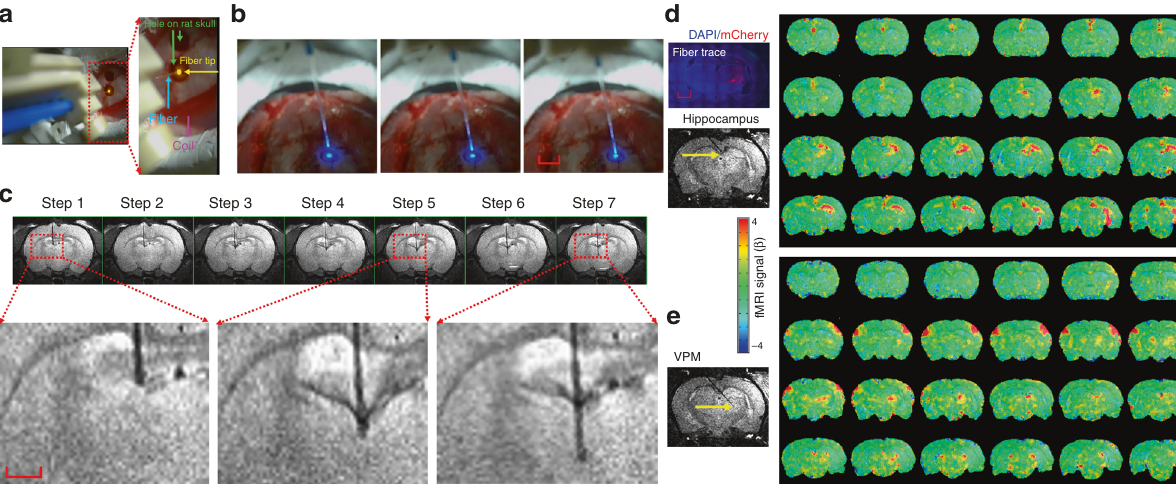
Fig. 2 Evaluation of MgRA for in vivo studies and brain-wide opto-fMRI patterns in multiple targets. a Snapshot of the optical fi ber (tip with 589 nm wavelength laser light, yellow arrow) positioned above the burr hole (green arrow) on the skull of an anesthetized rat with the driving piece of the head part. b Camera-based fi ber optic movement for three steps outside the rat brain. The fi ber tip delivers blue laser light (473 nm wavelength). The bright ring-structure above the rat skull is the RF surface coil. Scale bar, 2 mm. c Potential collateral damage from the choroid plexus when the fi ber was lowered to pass through the lateral ventricles, shown as a dark signal below the hippocampus. The step size was 300 µ m. Scale bar, 1 mm. d Left, histological image demonstrates ChR2-mCherry expression in most of the thalamus and part of hippocampus. Red, ChR2-mCherry; blue, 4 ′ ,6-Diamidino-2-phenylindole (DAPI). Right, the fi ber tip targets the hippocampal area and the BOLD fMRI map shows the activated area primarily located in the ipsilateral hippocampal structure. Scale bar, 2 mm. e The fi ber tip targets the ventral postero-medial (VPM) thalamus and map of BOLD activity was detected in bilateral vibrissal S1 cortex in response to blue light stimulation. (For both ( d ) and ( e ), 3D whole brain EPI: 400 μ m isotropic resolution, 1.5 s repetition time; stimulation block design: 8 s on 37 s off; laser pulse: 10 ms, 5 Hz, 3.7 mW/200 µ m core diameter of fi ber